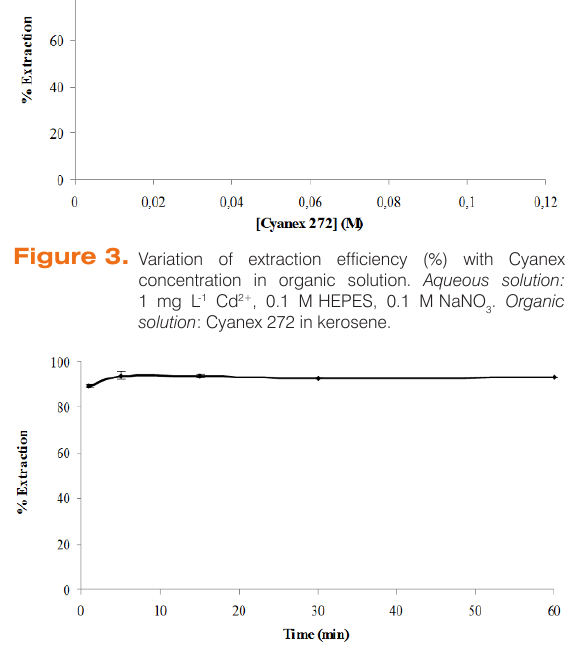
Figure 4. Variation of extraction efficiency (%) with agitation time. Aqueous solution: 1 mg L -1 Cd 2+ , 0.1 M HEPES, 0.1 M NaNO . Organic solution : 0.1 M Cyanex 272 in 3